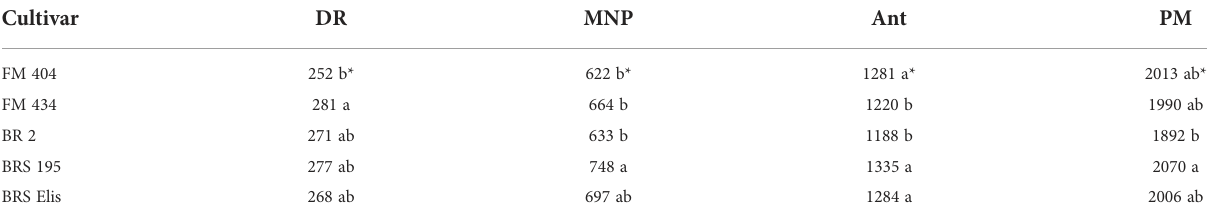
TABLE 1 External phenology of barley cultivars released at different decades in Brazil: thermal times (°Cd) from emergence (EM) to double ridge (DR), to the maximum number of spikelet primordia (MNP), to anthesis (ANT) and physiological maturity (PM) in 2011, 2012, and 2013 experiments. Cultivar DR